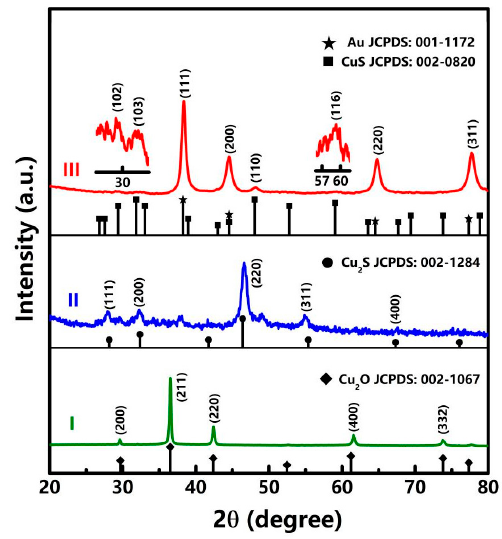
Figure 2. XRD patterns of the two intermediates (curve I and II) and final product (curve III) facilely mass-produced by the solvent approach.